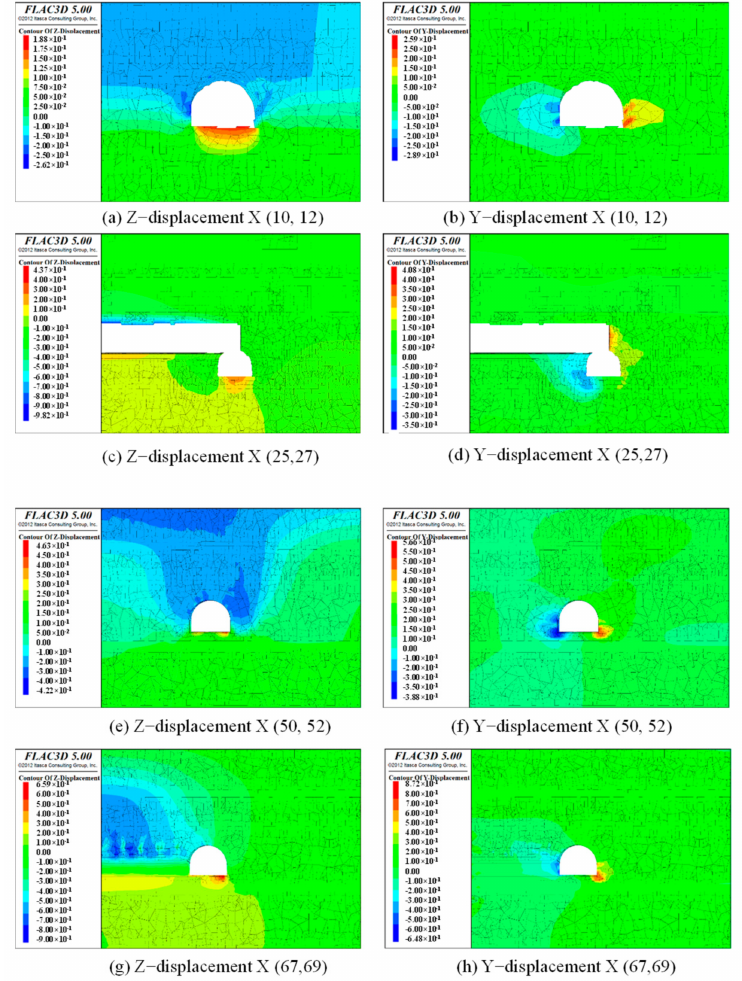
Figure 21. Supporting state after excavation of belt roadway head